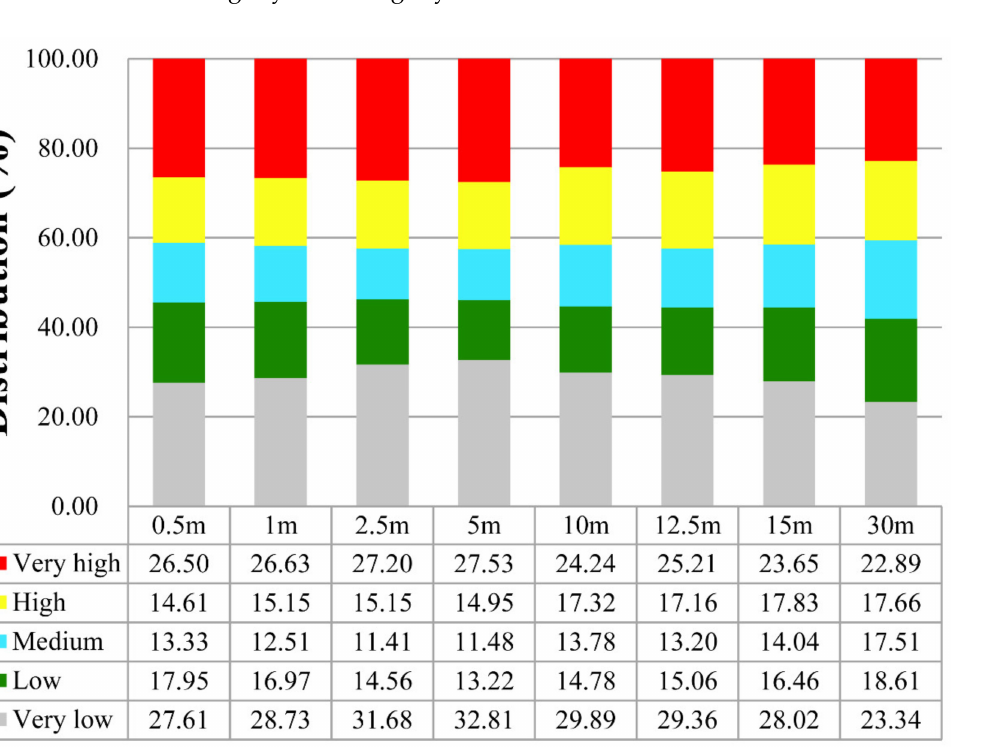
Figure 8. Percentages of susceptibility classes for each